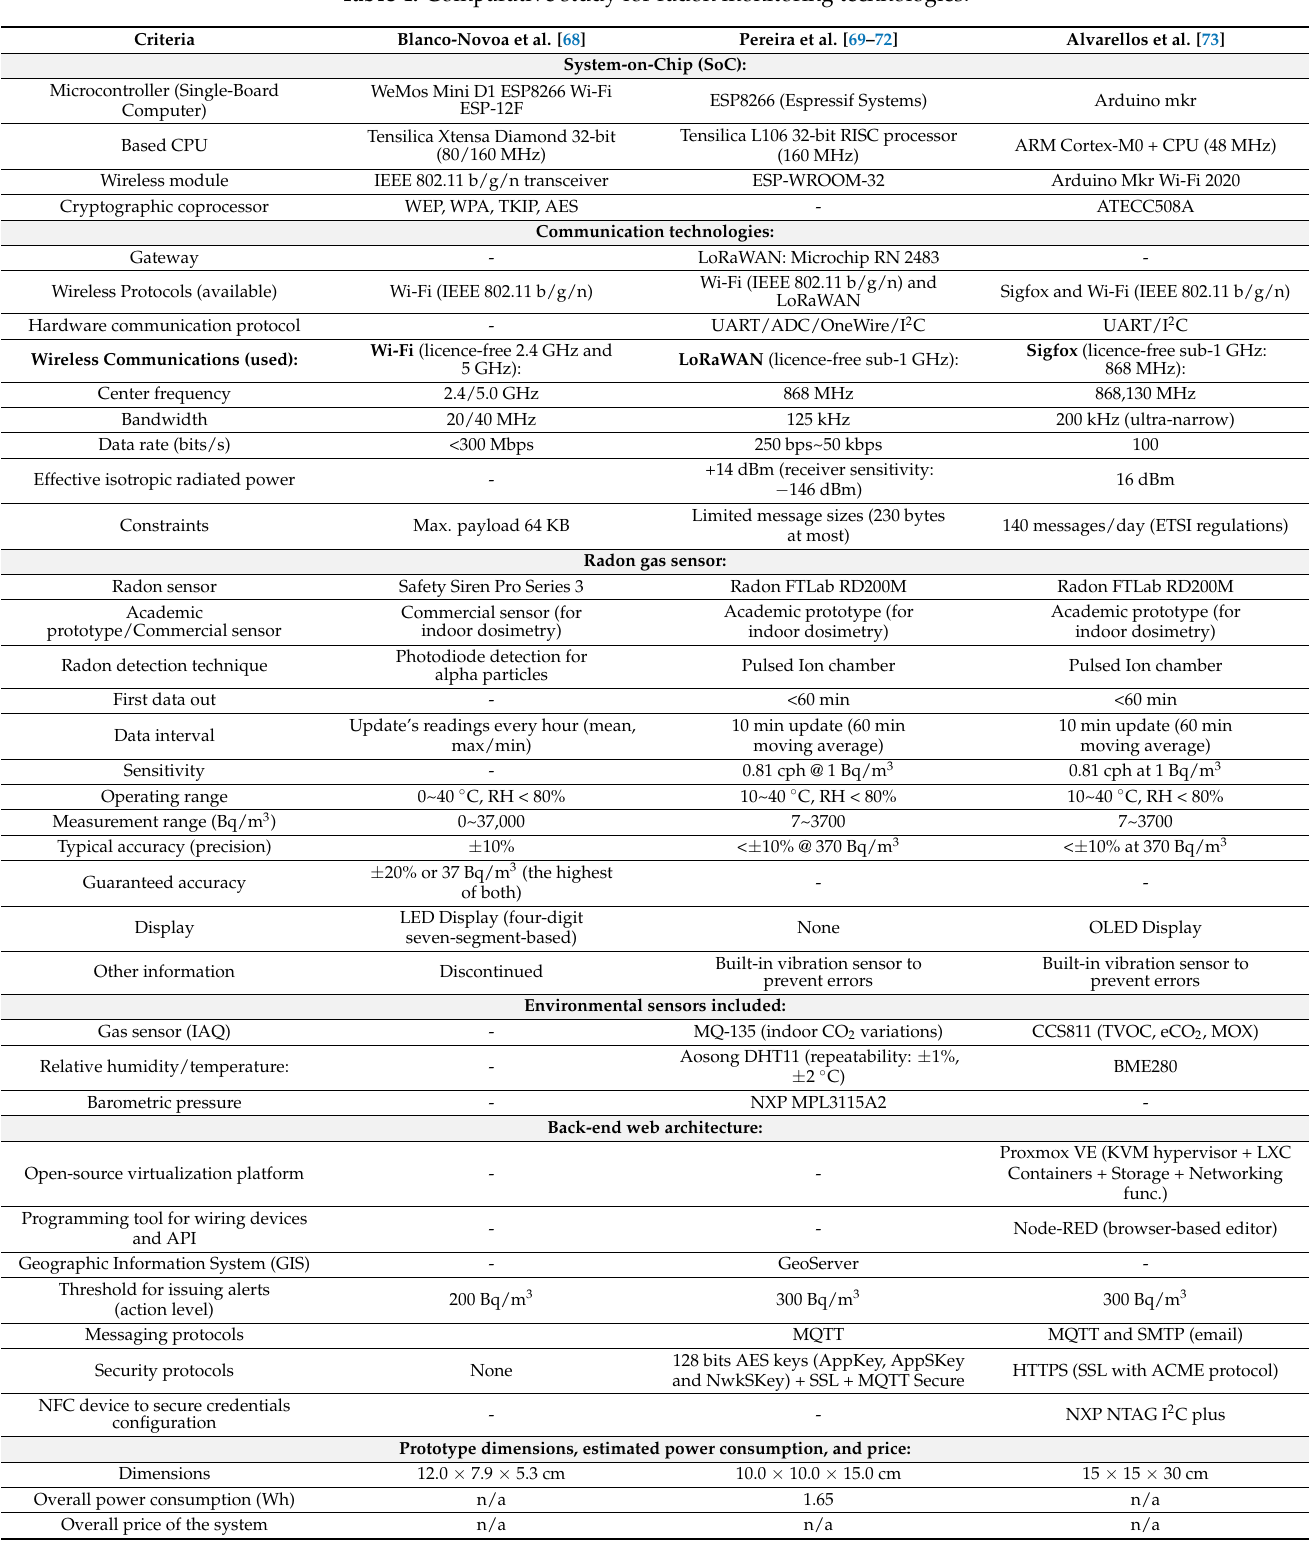
Table 4. Comparative study for radon monitoring